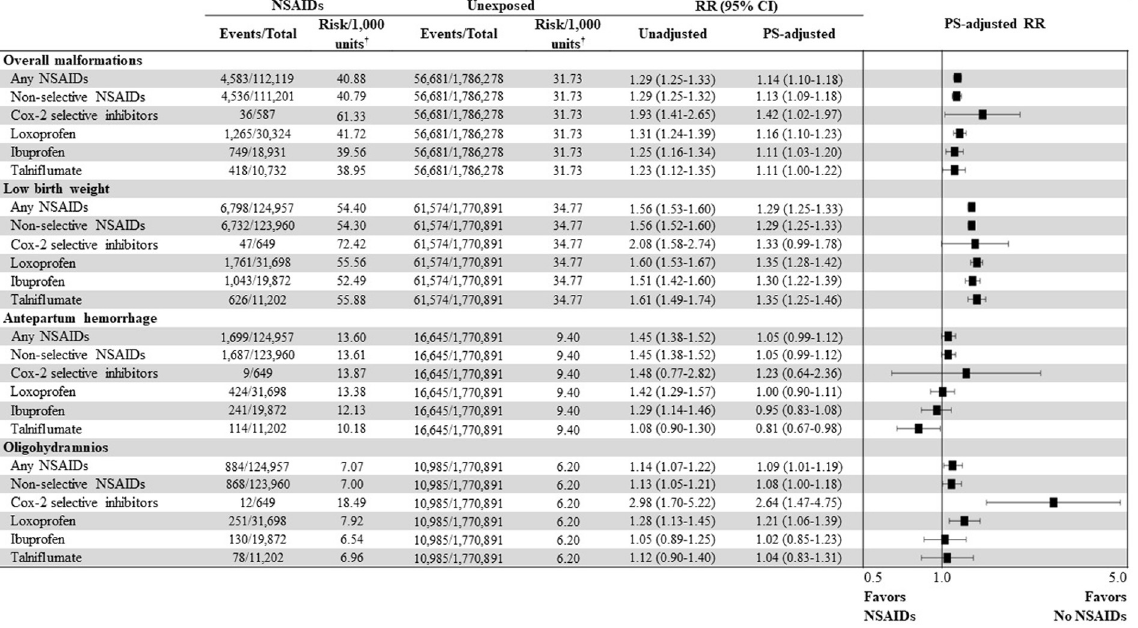
Fig 3. Risk of neonatal and maternal adverse outcomes associated with prenatal NSAID exposure during early pregnancy, depending on the type of NSAIDs and the three most frequently prescribed individual NSAIDs. CI, confidential interval; COX, cyclooxygenase; NSAID, nonsteroidal anti-inflammatory drug; PS, propensity score; RR, relative risk. � Units: births for outcomes of overall congenital malformations and low birth weights; pregnancies for outcomes of antepartum hemorrhage and oligohydramnios.